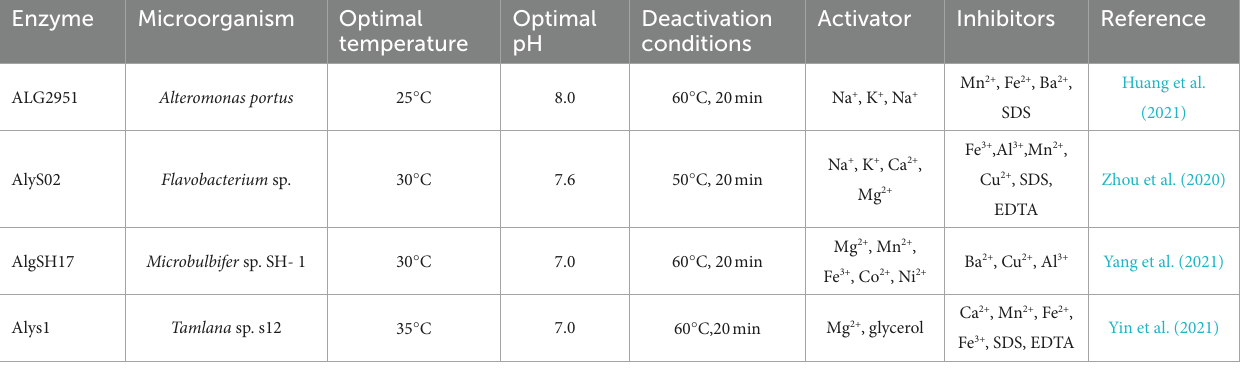
TABLE 3 Cold-adapted alginate lyases from various microorganisms and associated characteristics.